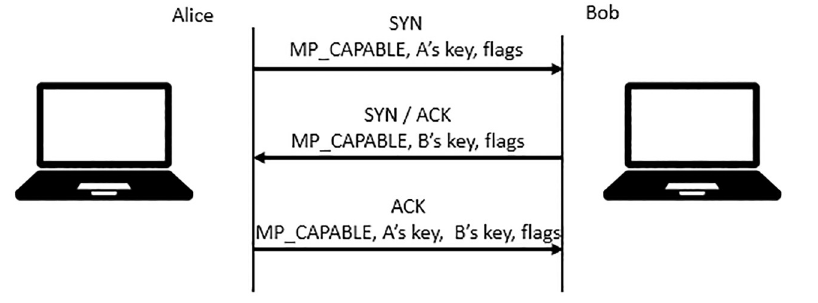
Fig 3. Initiating an MPTCP